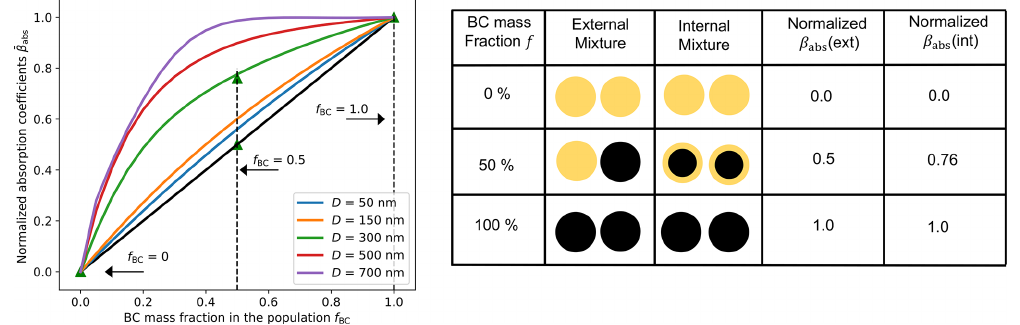
Figure 5. Normalized absorption coefficient as a function of BC mass fraction for five monodisperse populations with different sizes. The coating species is ammonium bisulfate with refractive index 1.47. Absorption coefficients are normalized by β abs of the population with f BC = 1 (pure BC). The black line is for BC in an external mixture. Colored lines are for BC in an internal mixture of different sizes. The table on the right sketches three 300nm internal and external populations with BC mass fraction of 0%, 50% and 100%. Black is for BC and yellow for coating